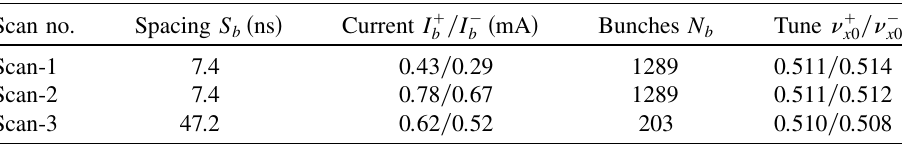
TABLE III. Beam conditions used in the horizontal scan, where the bunch spacing and the bunch current are averaged